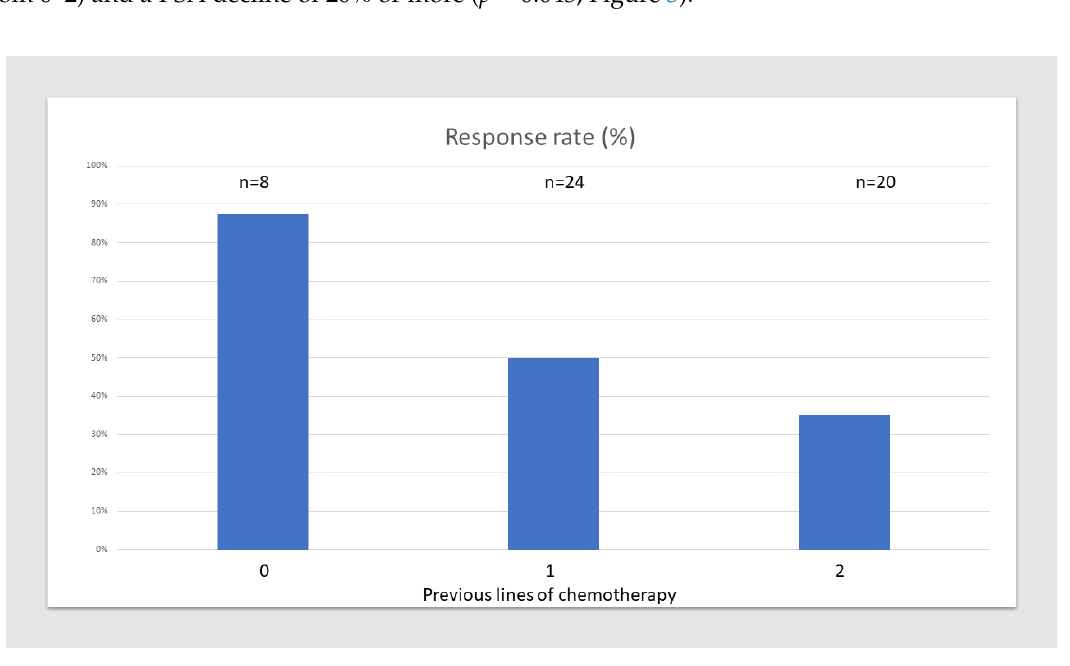
Figure 3. Response rate according to number of previous chemotherapy lines.